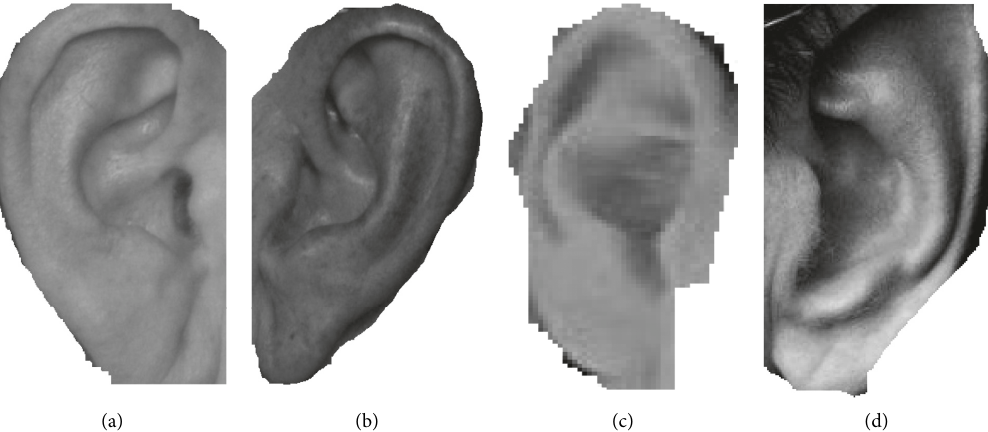
Figure 7: Examples of the extracted ear images. (a) Example ear extracted from 2D profile image of a female. (b) Example ear extracted from 2D profile image of a male. (c) Example ear extracted from facial image of a female. (d) Example ear extracted from facial image of a